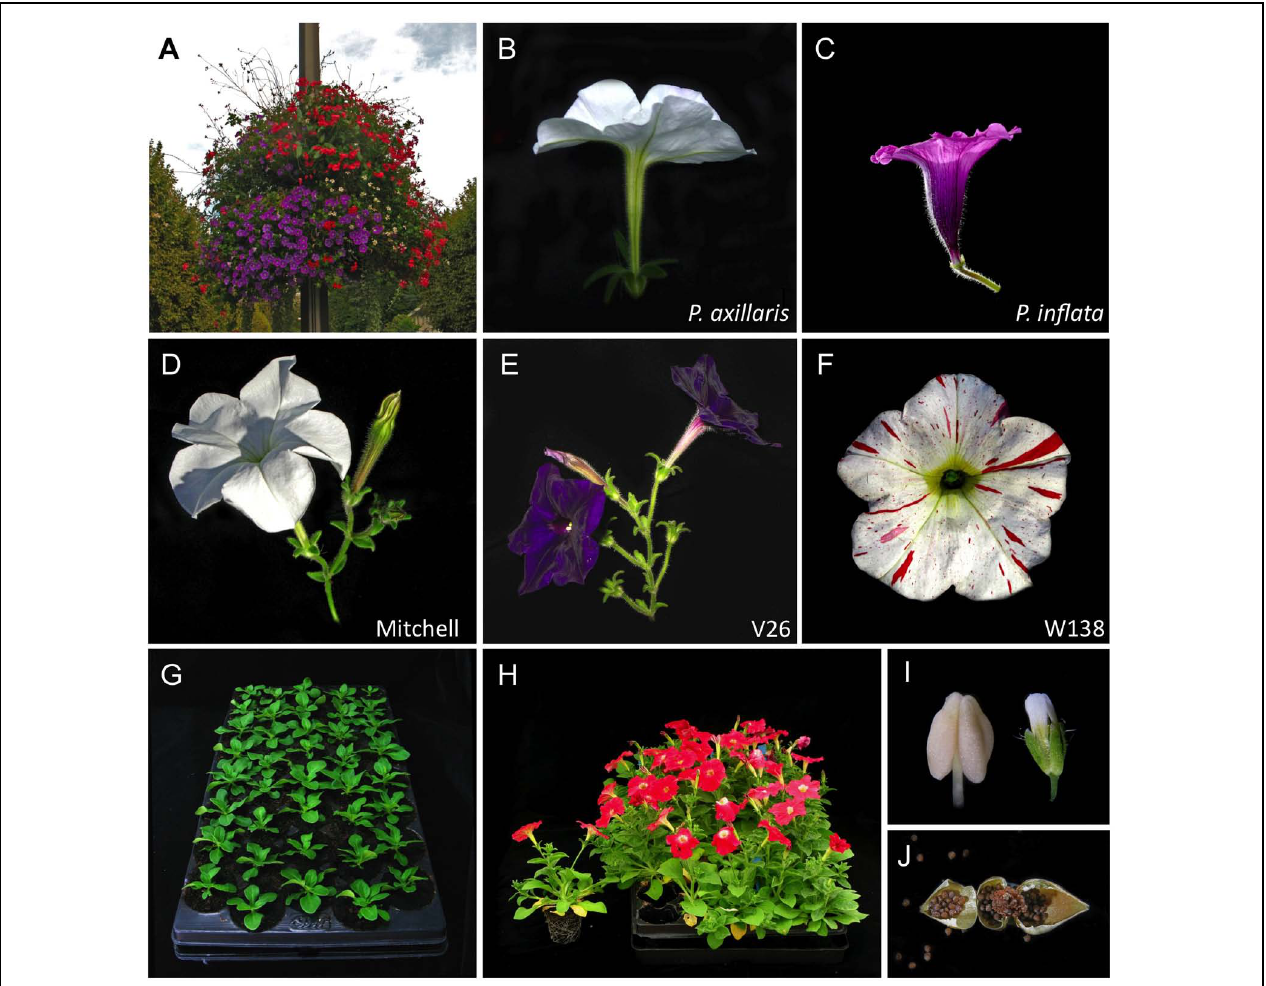
FIGURE 1 | Petunia species, varieties, and growth characteristics. (A) Petunia is world-wide one of the most popular bedding plants, nowadays frequently used also in hanging baskets for city decoration (Vienne, France). (B,C) Petunia axillaris and P. inflata are two wild species native to South America with contrasting flower architecture, pigmentation, and pollination syndromes (Stuurman et al., 2004). From the early 19th century onward, these two species [or closely related (sub)species thereof] were used as parents in interspecific crosses, providing the genetic material for modern P. hybrida cultivars (Stehmann et al., 2009;